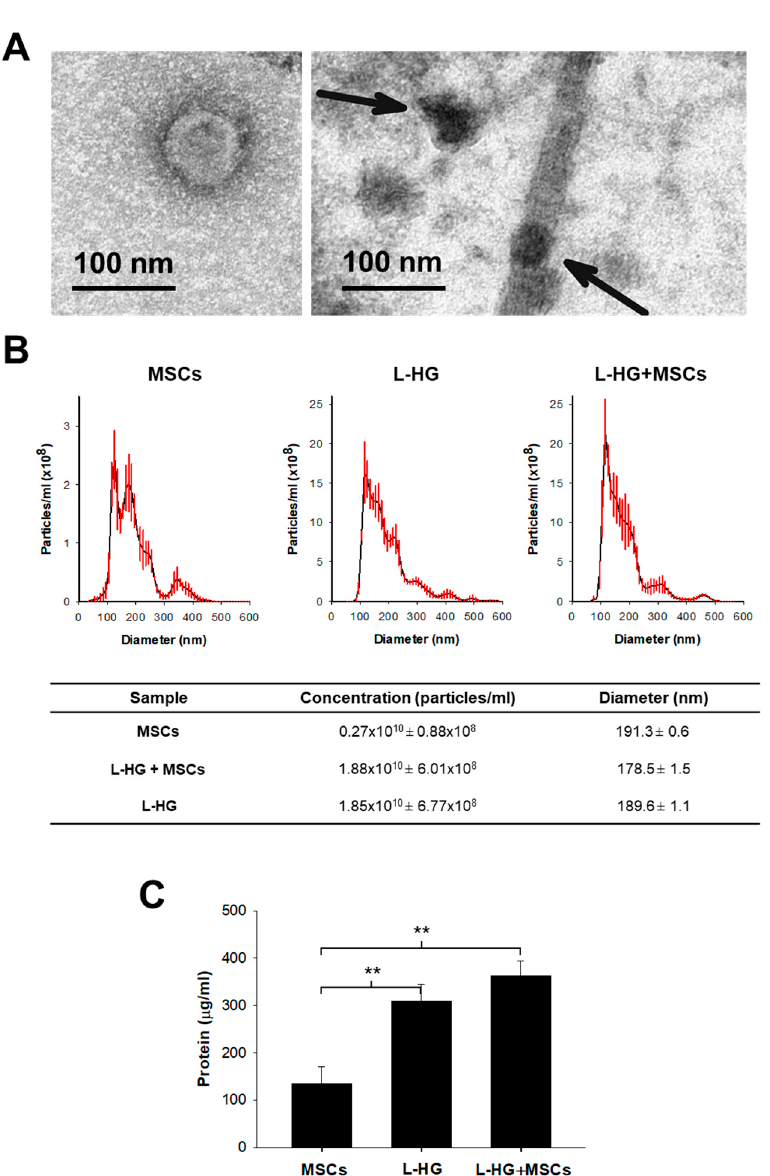
Figure 2. Microvesicle quantification and characterization in all groups. ( A ) TEM images showing an isolated vesicle ( left ) and ECM-bound vesicles ( right ). ( B ) NTA analysis revealed that the number of ECM-vesicles released from 3-days washed L-HG were still higher than EVs secreted by MSCs cultured in plastic. The NTA profile also shows that vesicles released from both L-HG and MSCs have a very similar profile in size distribution. ( C ) The protein content of the particles isolated in each condition confirmed the NTA quantification showing a 3-fold increase in L-HG with respect to MSCs. ** p < 0.01 ( n =